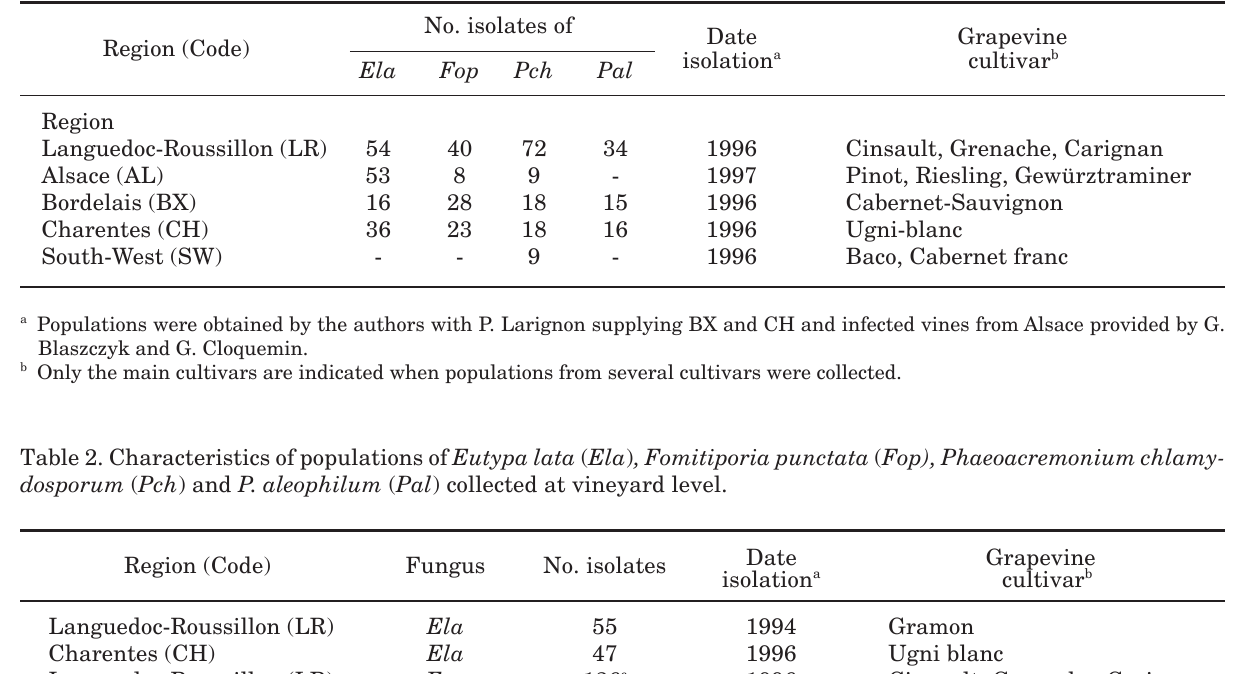
Table 1. Characteristics of populations of Eutypa lata ( Ela ) , Fomitiporia punctata ( Fop), Phaeoacremonium chlamy- dosporum ( Pch ) and P. aleophilum ( Pal ) collected at regional